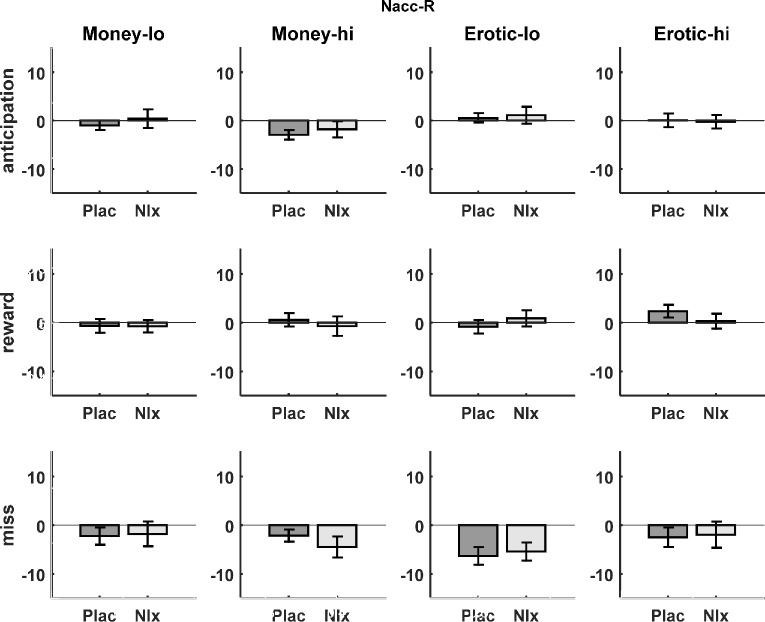
Right ventral striatum (nucleus accumbens) fMRI responses (arbitrary units) for all stimuli (money/erotic, high/low) and time-points (anticipation, outcome: reward, outcome: miss) under placebo (Plac) and naloxone (Nlx).Error bars represent standard error of the mean.